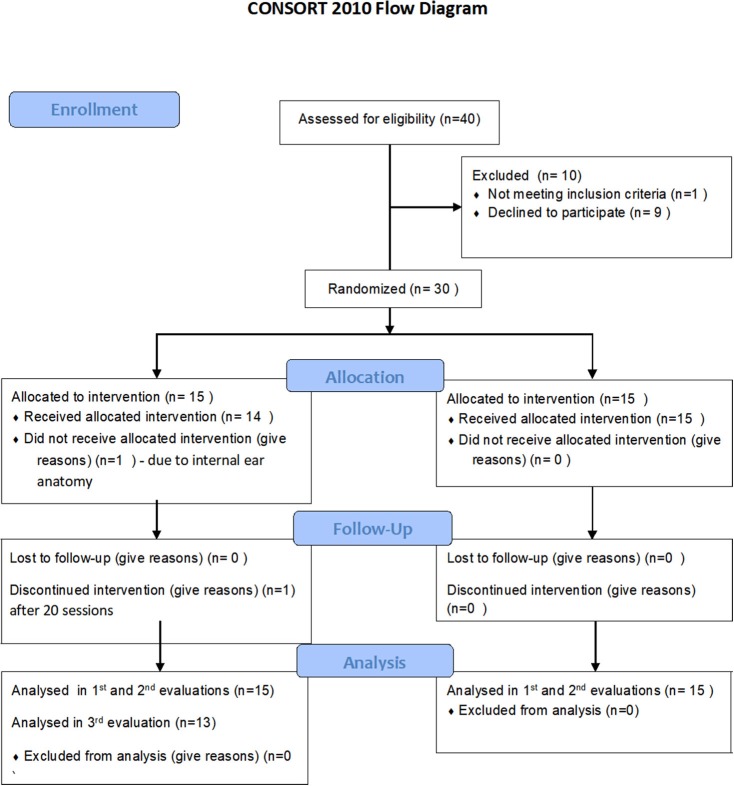
Participants flowchart.